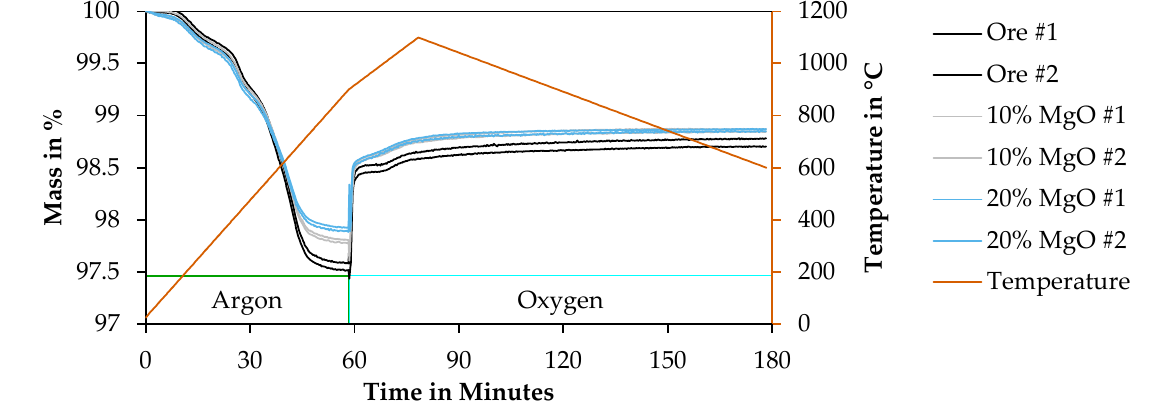
Figure 9. Thermogravimetric analysis of chromite and chromite-MgO mixtures.